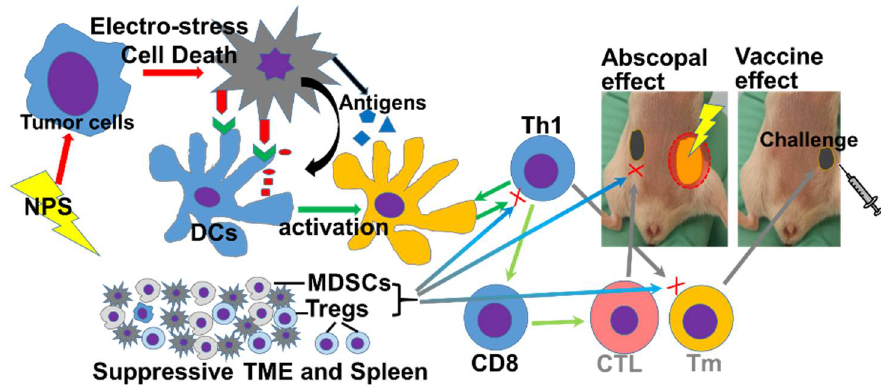
Figure 8. Proposed mechanisms of the failed induction of immune response with NPS treatment in the Pan02 tumor. NPS: Nano-pulse stimulation; DCs: Dendritic cells; MDSCs: Myeloid derived suppressor cells; Tregs: T regulatory cells; TME: tumor microenvironment; Th1: type I help cells. CTL: cytotoxic T cells. Tm: memory T cells.